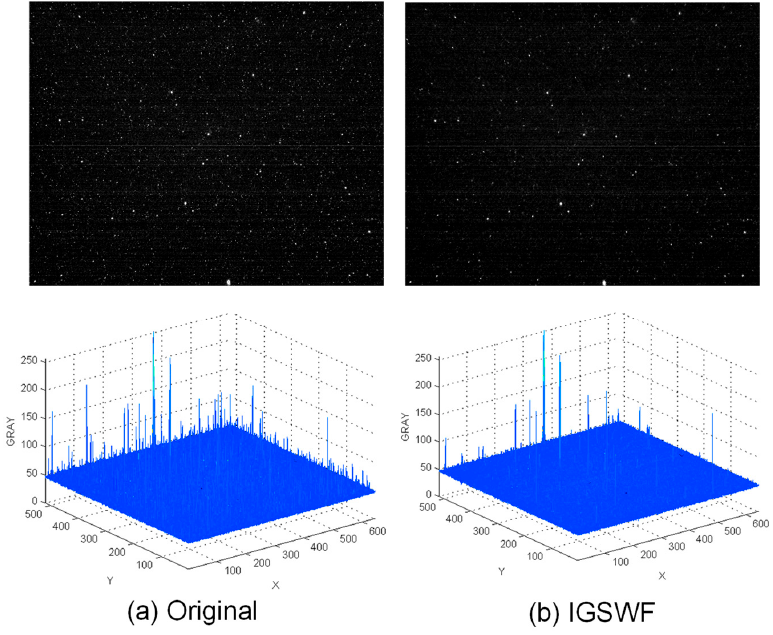
Figure 12. Comparison before and after denoising in SAA area 2: ( a ) the star image and the three-dimensional distribution of the grayscale before denoising; ( b ) the star image and the three ‐ dimensional distribution of the grayscale after IGSWF processing.